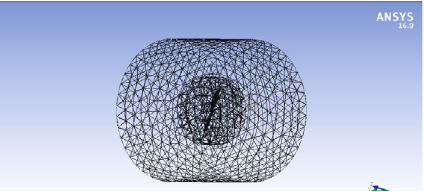
Figure 14: Design-1 (generated mesh). Mesh type: unstructured tetrahedral mesh. Nodes: 120561. Elements: